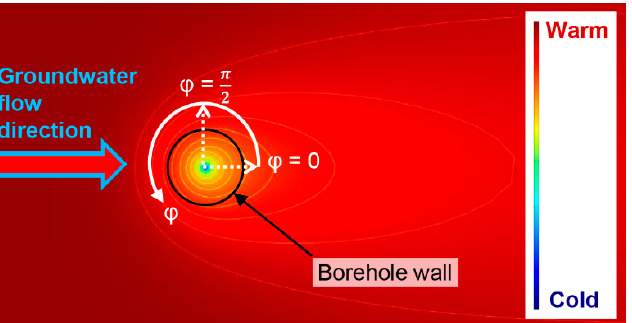
Figure 1. Temperature distribution around a heat sink with groundwater advection.